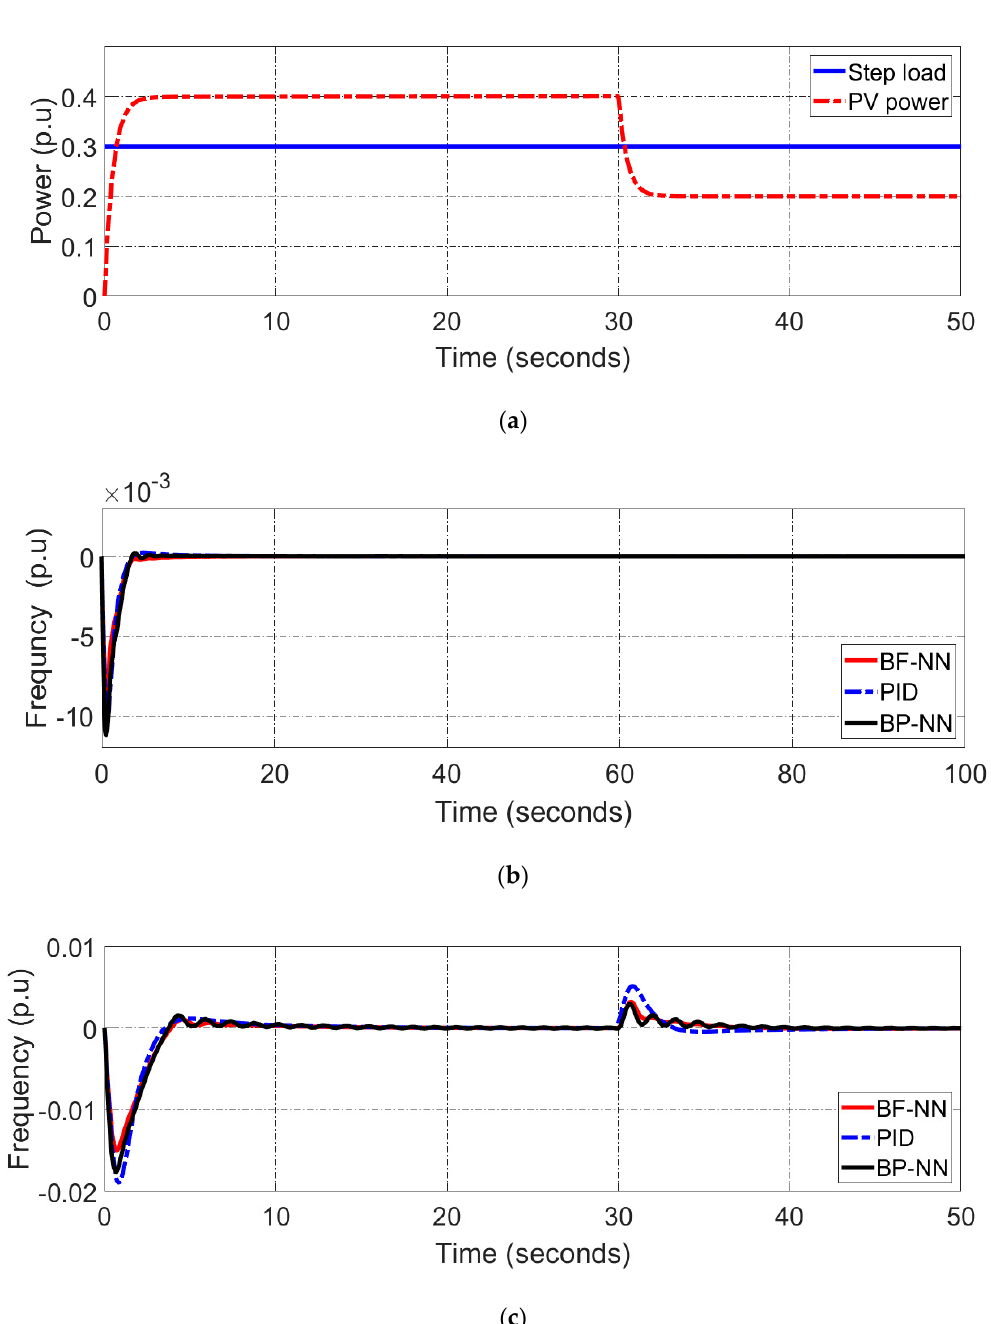
Figure 10. Division signals in an initial operating state of ( a ) input power, ( b ) output frequency without PV generation, and ( c ) output frequency with PV generation.